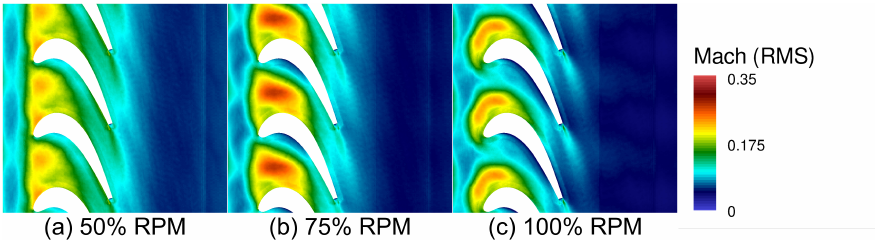
Figure 21. Contours of RMS value of Mach number near the stator–rotor region at 50% span location of the rotor blade for: ( a ) 50% RPM; ( b ) 75% RPM; and ( c ) 100%